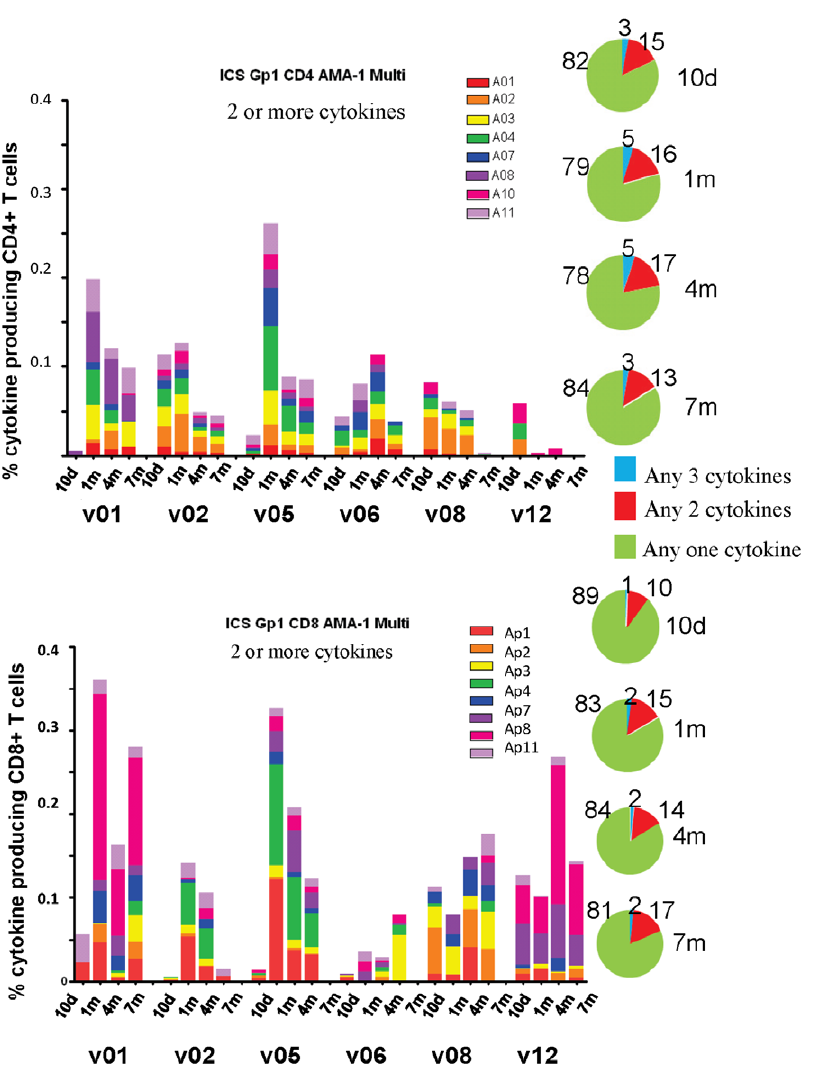
Figure 10. Multifunctional CD4 + and CD8 + T cells of serial bleeds of volunteers in Group 1 with AMA1 peptide pools. A and C : Multifunctional (any two cytokines) CD4 + and CD8 + T cell activities of each volunteer at 10 d, 1, 4, and 7 m after immunization (subtracting pre- immunization values) are displayed using color-coded AMA1 peptide pools. At 1 month, CD4 + multi responses (geomean 0.072% CD4 + T cells, std dev 94) and CD8 + multi responses (geomean 0.13% CD8 + T cells, std dev 14) were similar. B and D : Pie charts representing the proportion of the cytokine response indicated by cytokine subsets as shown; numbers on pie charts represent per cent of that subset of the total cells.